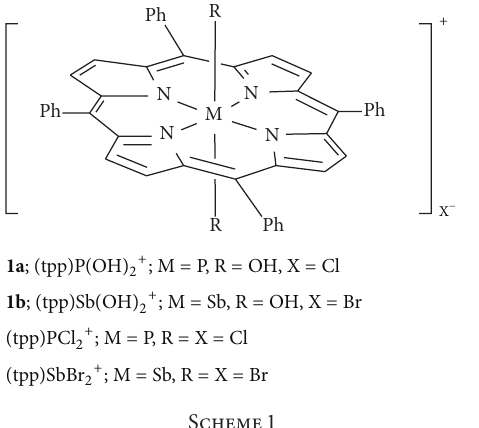
) of 2a – 2g on carbon W